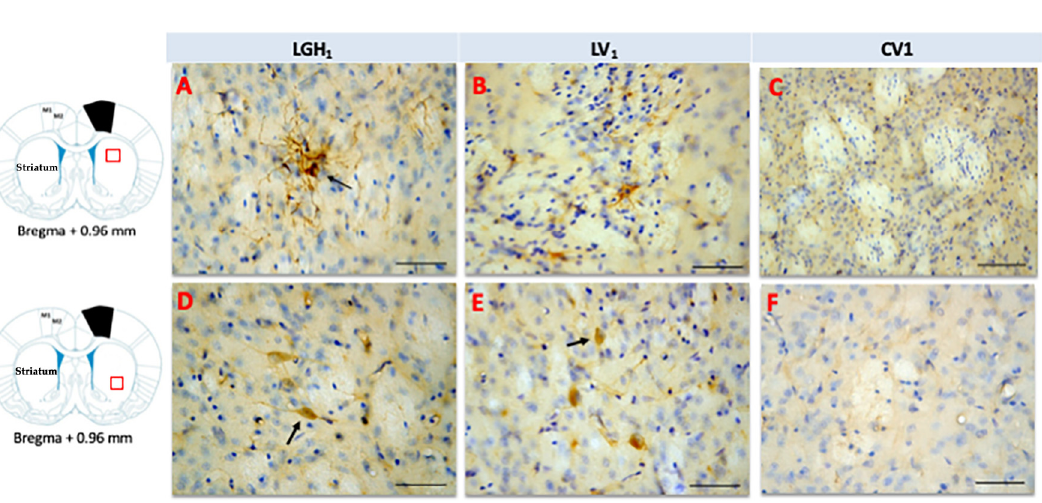
Figure 6. Nestin expression in the striatum ipsilateral to the lesion of animals sacrificed at 25 dpi. Nestin re-expression in the striatum ipsilateral to the lesion of animals belonging to the three experimental groups LGH1 ( A , D ), LV1 ( B , E ) and CV1 ( C , F ). The three microphotographs to the right correspond, in each experimental group, to the red box indicated in the scheme. Coronal sections at + 0.96 mm from Bregma. The arrow in ( A ) points to a reactive astrocyte at the striatal white matter. The arrows in ( D , E ) point to nestin + neurons in the striatal gray matter. The re-expression of nestin in the striatum was observed from AP = + 2.52 mm to AP = − 0.12 mm with respect to bregma. Scale bar = 100 µ m. In the scheme, the black trapezoid indicates the place where the lesion was produced.